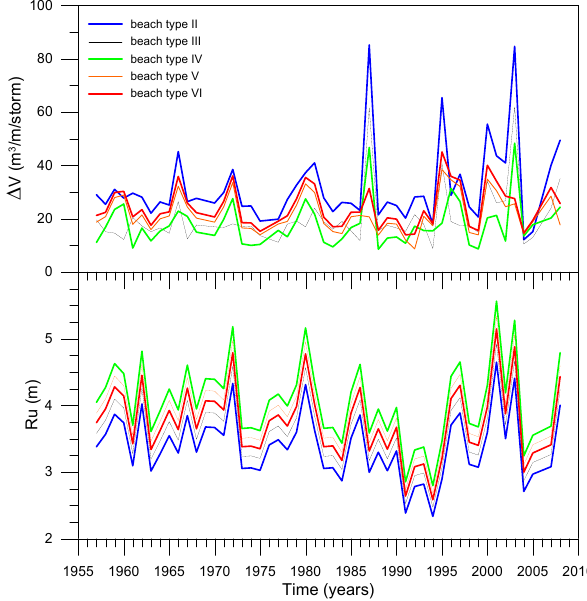
Fig. 6. Hazards time series at the central part (sector III) of the Catalan coast (see location in Fig. 1) for representative beach types. Top: erosion; bottom: